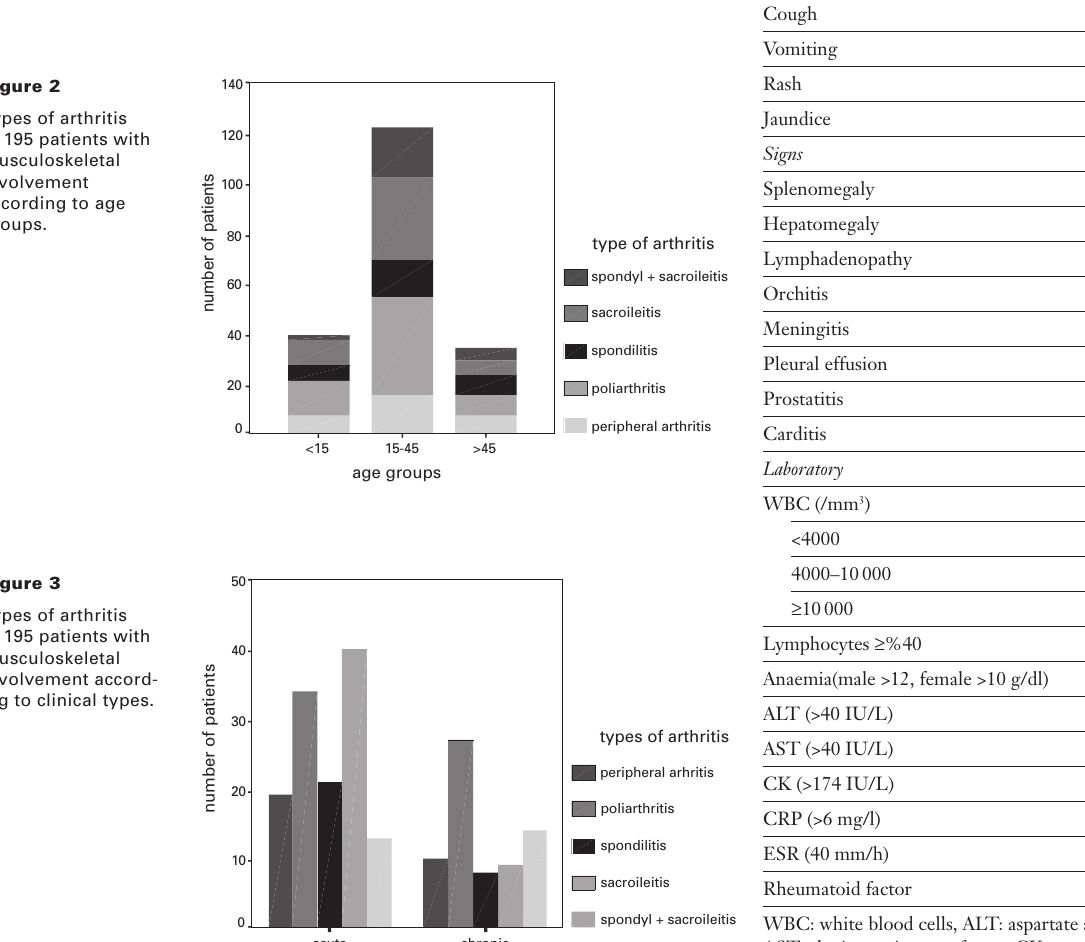
CRP: C-reactive protein, ESR: erythrocyte sedimentation rate